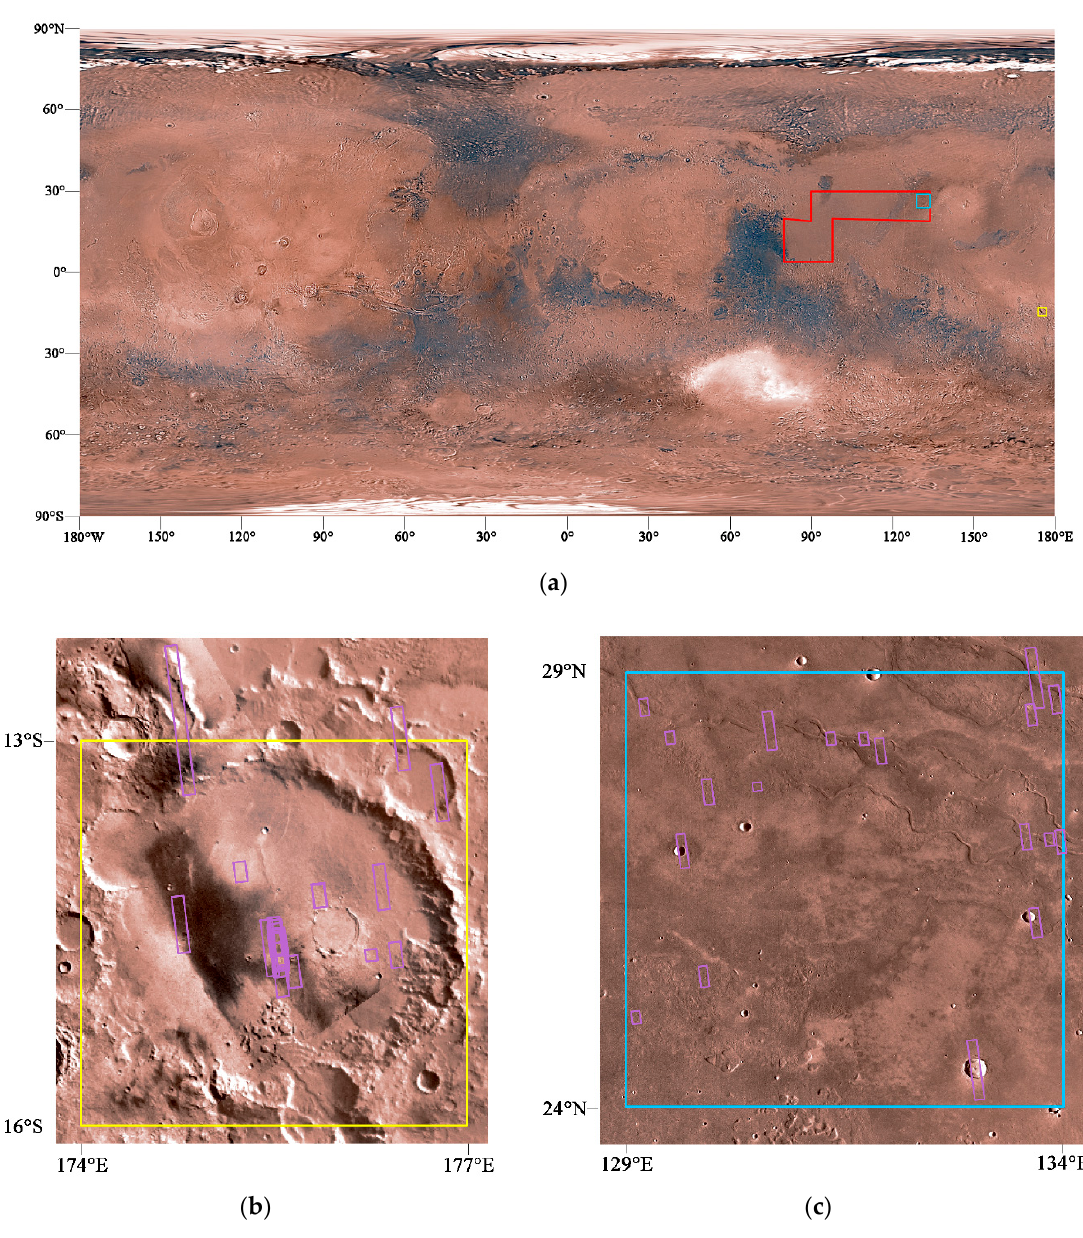
Figure 1. The schematic diagram of the research area and the footprints of images. ( a ) The red polygon represents the candidate landing area of China’s Mars Mission (Tianwen-1) [24], the blue rectangle represents the study area (part of the candidate landing area), and the yellow rectangle represents the inspection area of the Spirit rover. The base map is global color mosaic of the Mars by Viking Orbiter [25]; ( b ) The footprints (purple rectangle) of images in the inspection area of the Spirit rover; ( c ) The footprints (purple rectangle) of images in the candidate landing area.